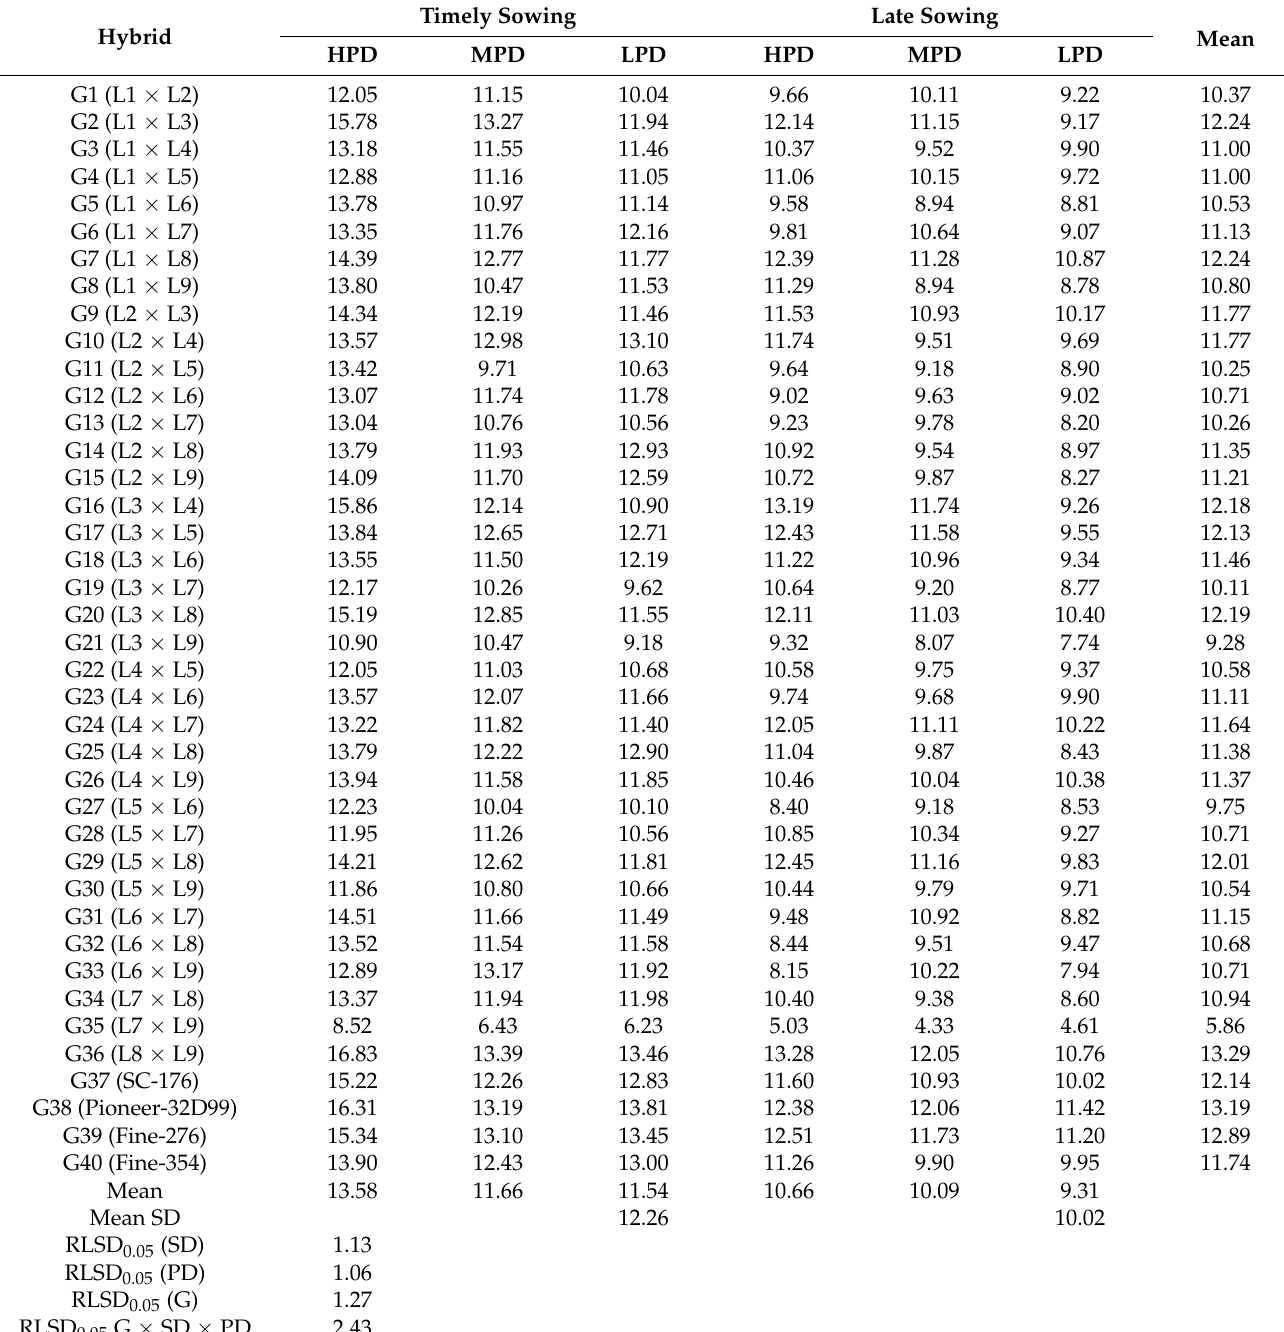
Table 4. Impact of sowing date and planting density on grain yield (ton ha − 1 ) of the evaluated 40 maize